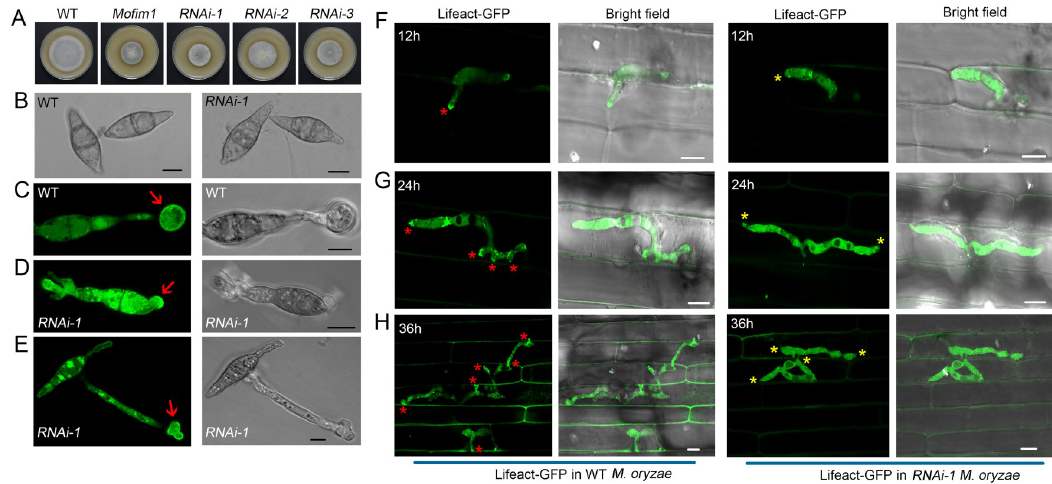
Fig 9. MoFim1 functions in actin cytoskeleton organization in invasive hyphae, which is required for hyphal expansion in rice cells. (A) Images of 7-d-old cultures including WT, Mofim1 , and three MoFim1 silencing strains. (B) Images of conidia in WT and RNAi-1 strains. Bars = 10 μ m. (C–E) Morphology and actin organization in WT (C) and RNAi-1 strains (D and E) . The red arrows indicate the induced appressorium in the WT and the RNAi-1 strains labeled with Lifeact-GFP. Bars = 5 μ m. (F–H) Actin organization at different time points in invasive hyphae of WT (left panels) and RNAi-1 (right panels). The red asterisks indicate actin accumulation at the hyphal tip or the narrow site in which the hyphae penetrate into neighboring cells. Yellow asterisks indicate the area described above in RNAi-1. Bars = 5 μ